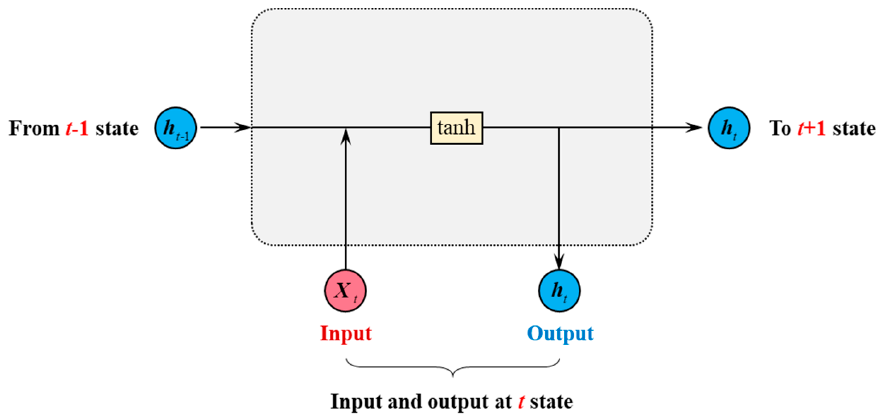
Figure 2. The internals of a Simple Recurrent Neural Network (RNN) memory cell.